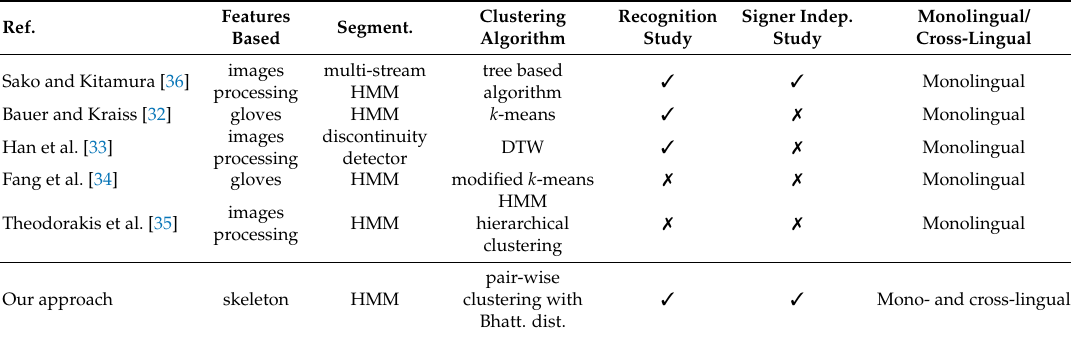
Table 13. Comparison of our sign language hand movement subunit studies with existing studies.